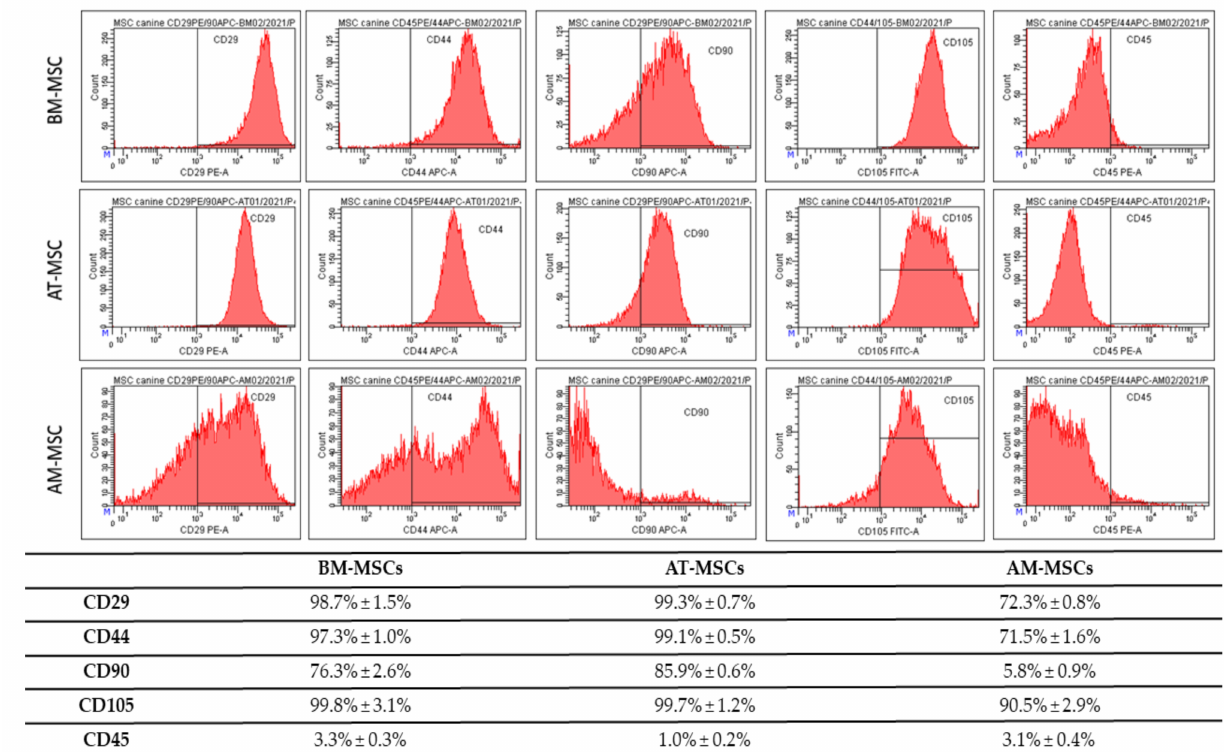
Figure 3. Results of the CD analyses from passage 3 (P3). The BM-MSCs showed positivity for CD29 (98.7% ± 1.5%), CD44 (97.3% ± 1.0%), CD90 (76.3% ± 2.6%), CD105 (99.8% ± 3.1%) and low expression for CD45 (3.3% ± 0.3%). The AT-MSCs showed high expression of CD29 (99.3% ±